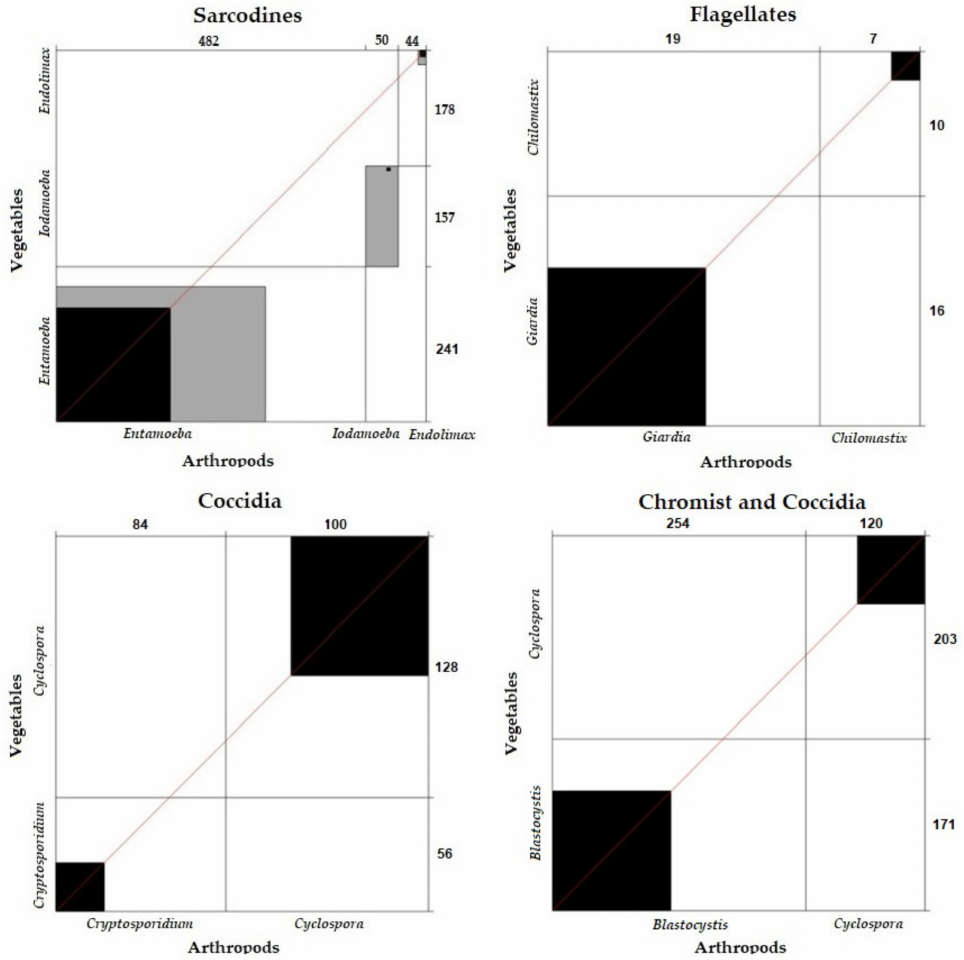
Figure 11. Concordance of parasite frequency between vegetables and arthropods according to parasite